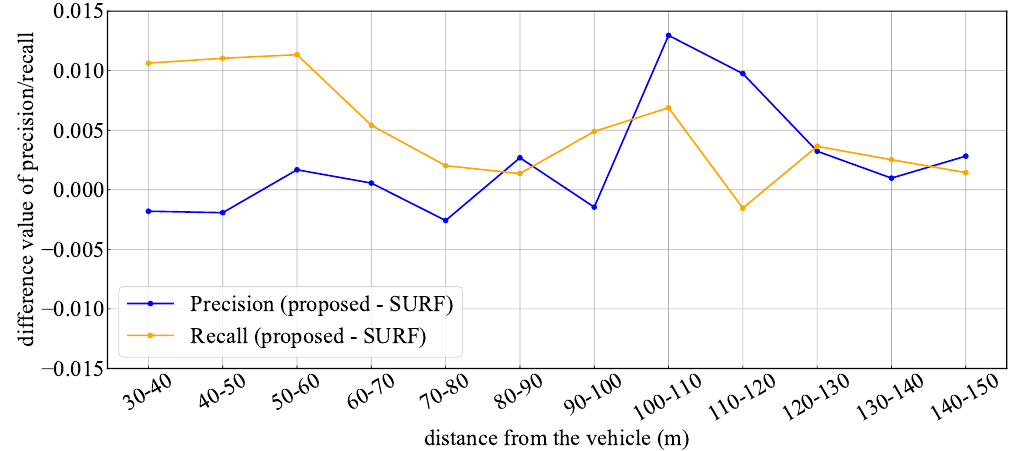
Figure 18. Difference value of precision/recall between the proposed method and sped up robust features